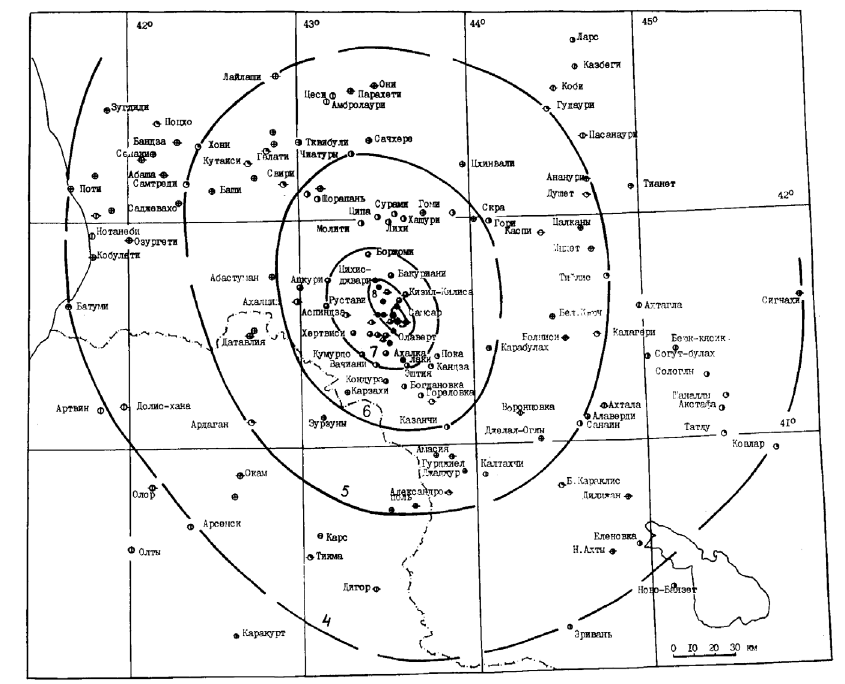
Fig. 7. Isoseismal map of 31 December 1899, Akhalkalak earthquake compiled by N.V. Shebalin and N.G. Mokrushina based on materials from primary sources - see the scheme in fig. 5 (from Tatevossian et al. ,